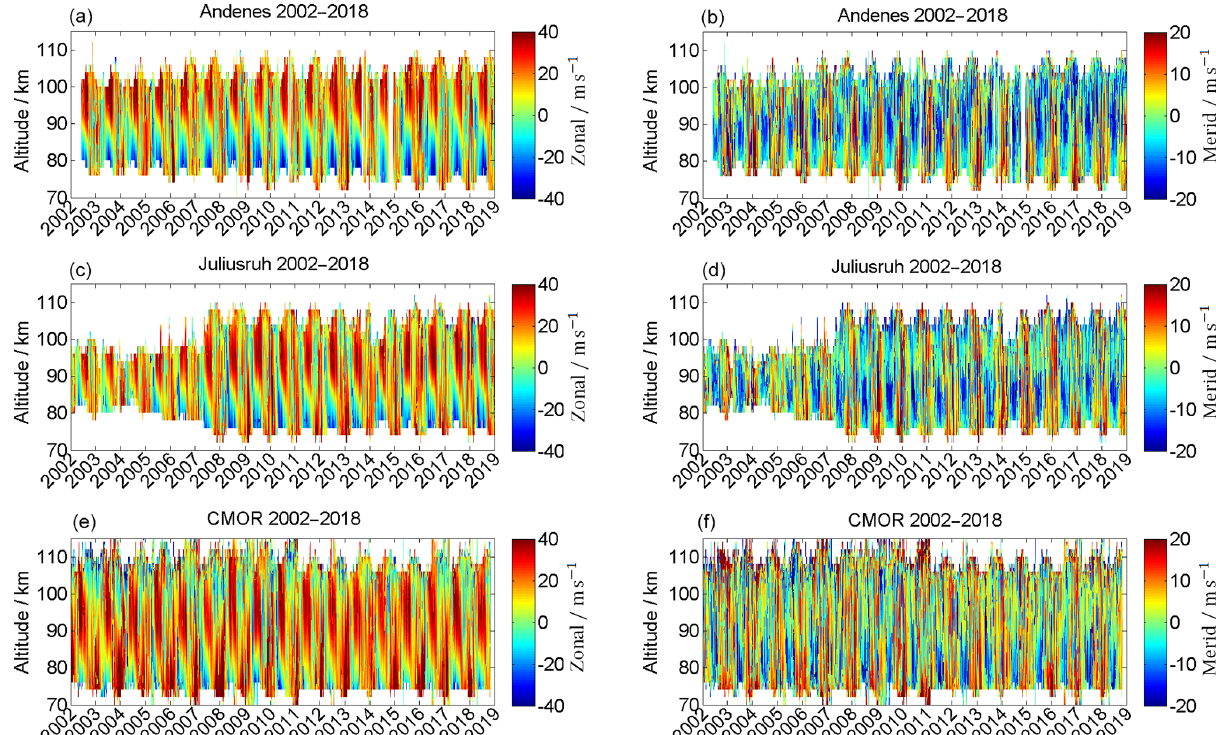
Figure 3. Observed zonal (a, c, e) and meridional (b, d, f) wind components for Andenes (a, b) , Juliusruh (c, d) , and CMOR (e, f) for the locations according to available data series. Note the different labels of the color